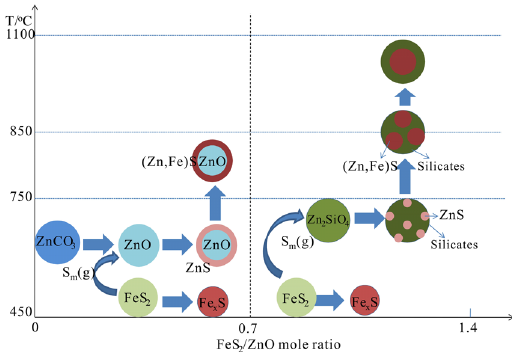
Figure 9. Proposed scheme diagram for sulfidization of refractory zinc oxides